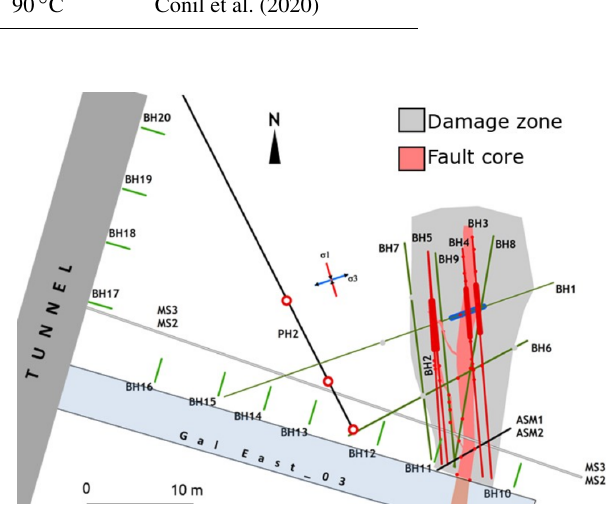
Figure 2. Simplified map of the CHENILLE borehole layout. The geometry of the fault zones was determined from borehole logging and geological mapping from the galleries’ floor, walls, and roof. The three main components of the fault zones are represented in this sketch: the fault core (red), the damage zone (grey), and the undisturbed protolith